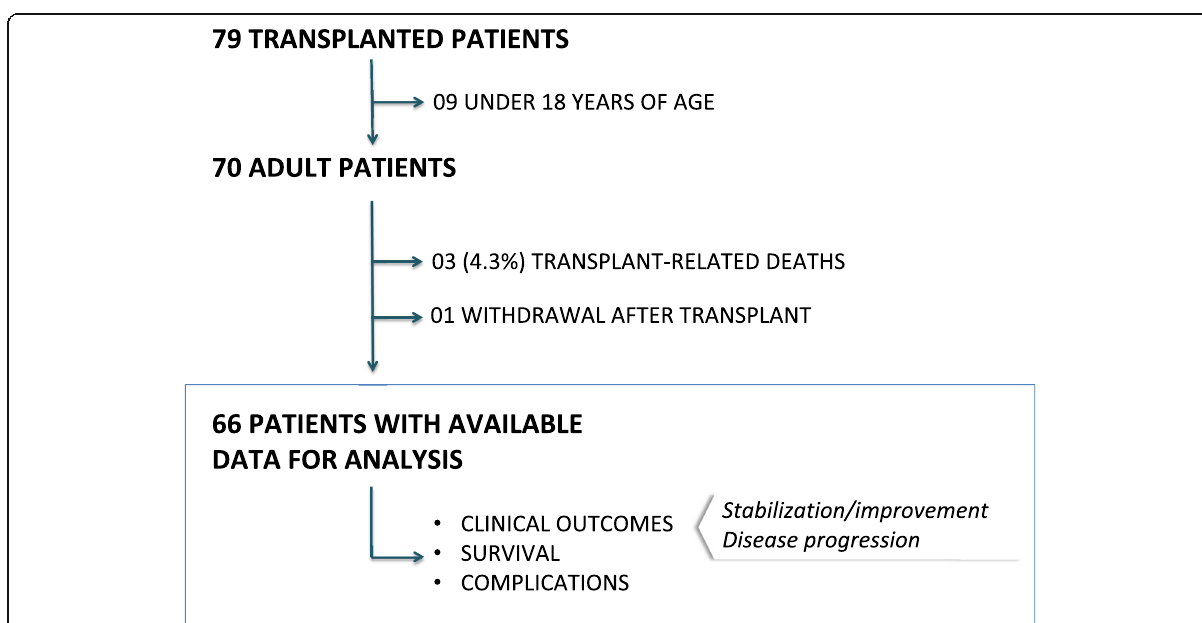
Fig. 2 Number of patients included in the retrospective study. From the initial 79 patients transplanted from 2009 to 2016, nine were under 18 years of age and were therefore excluded. Three patients died due to transplant-related complications (sepsis, complications of acute acalculous cholecystitis and acute cyclophosphamide-induced cardiotoxicity) and therefore did not have follow-up data. One patient voluntarily left the study after transplantation and was lost to follow-up (alive in December 2019, as confirmed by phone